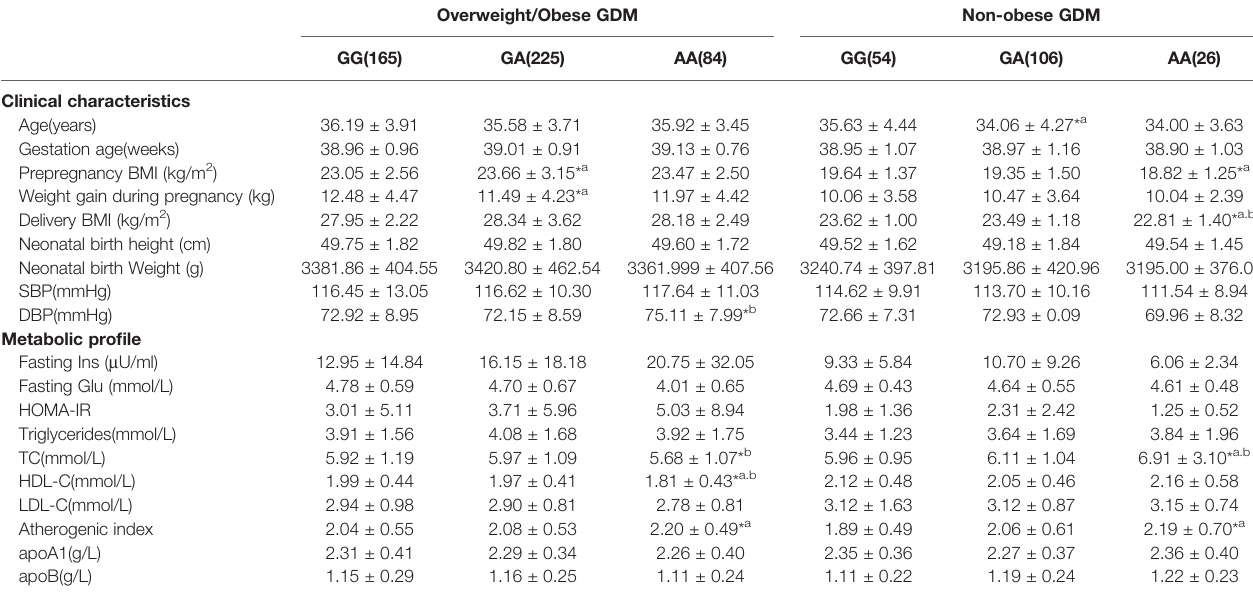
TABLE 5 | Clinical characteristics and metabolic pro fi le of ABCA1 rs2230806 genotypes in overweight/obese and non-obese GDM